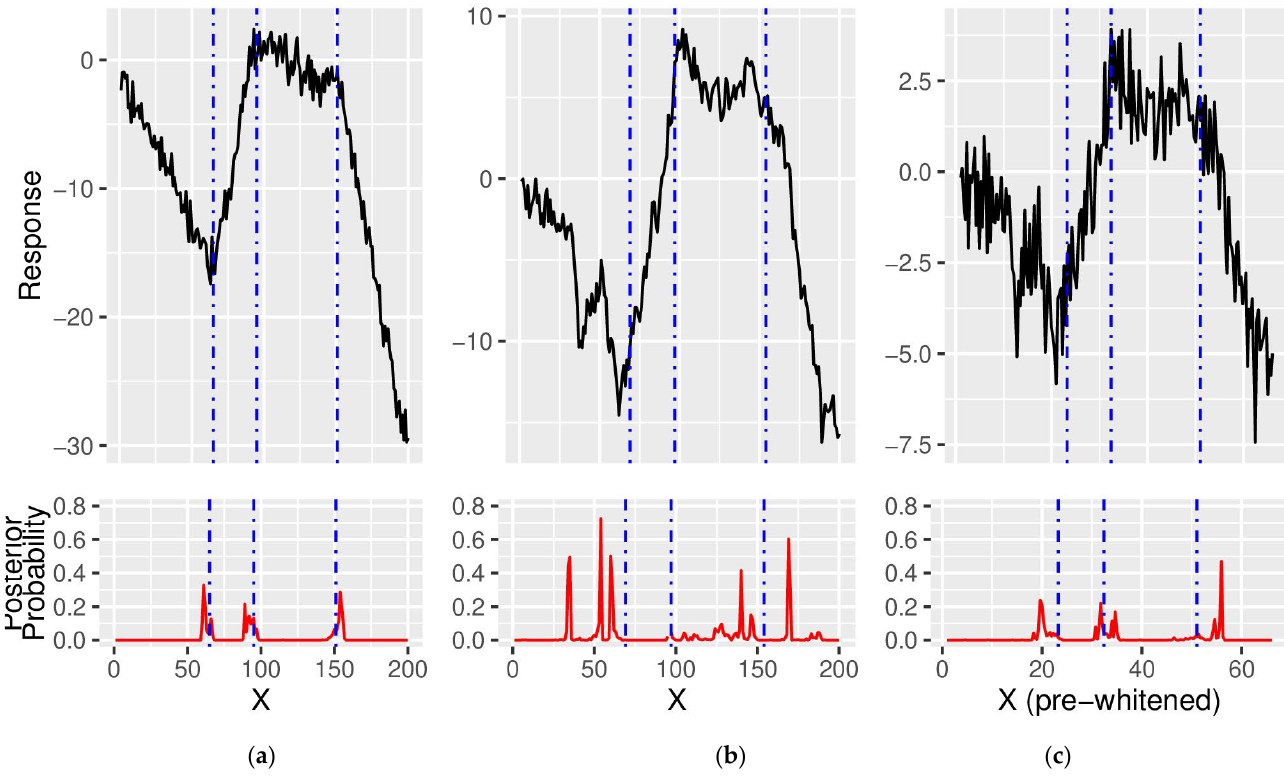
Figure 1. Detecting Change Points in the Presence of Autocorrelation. ( a ) A simulated dataset with 3 change points that contains only white noise. ( b ) Autocorrelation is added to (a) using ρ = 0.8. ( c ) The data in ( b ) after pre-whitening. The inferred location of change points is indicated below each figure, while their exact location is indicated by dotted vertical lines. Pre-whitening helps to eliminate spurious change points, but the location of the true change points becomes more difficult to correctly infer.